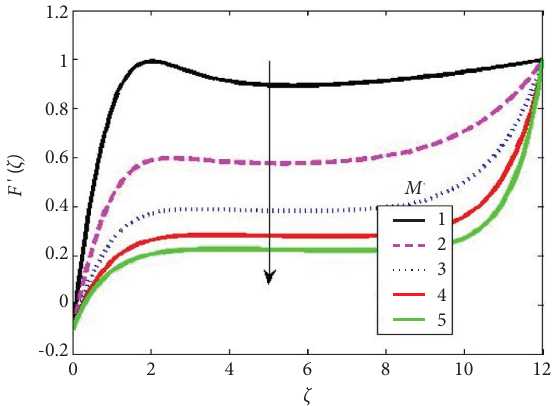
Figure 5: Efect of unsteady parameter on the temperature